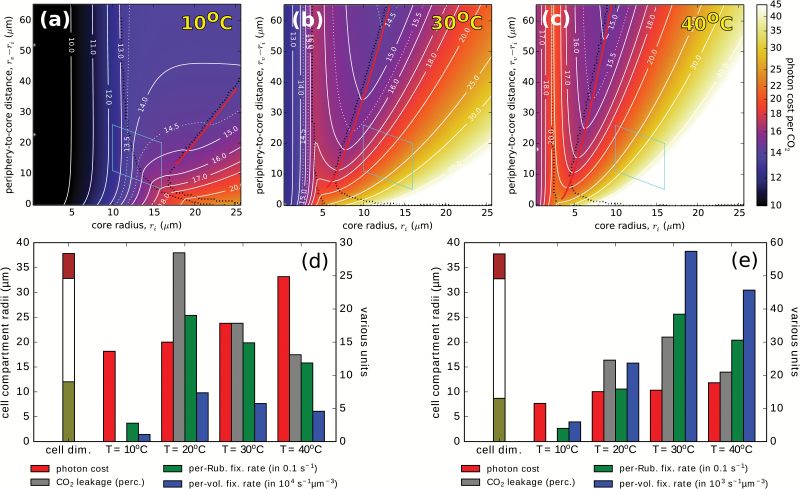
Temperature dependence of C4 photosynthesis. (a–c) C4-optimized photon cost landscapes at ambient temperatures of 10, 30, and 40 °C, plotted as Fig. 3 (20 °C). (d) and (e) Comparisons of the CO2 leakage, photon cost, and assimilation rates at two fixed cell geometries at various temperatures. The three compartment radii in (d) and (e) are marked on the left-most tricolour meters, and can be read on the left y-axis. The values of other quantities are to be read on the right y-axis. The comparison in (d) is taken at a point in the photon cost landscape that lies on the optimal-geometry line at 20 °C, with a photon cost (at 20 °C) of 15 photons per CO2. The comparison in (e) is taken at a point that lies on the optimal-geometry line at 30 °C, with a photon cost (at 30 °C) of 15.5 photons per CO2. The first point lies within the observed range of Bienertia cell dimensions; the second is positioned slightly outside this range. The CO2 leakage is zero at 10°C because both points lie within the C3 region of the photon cost landscape at that temperature. Parameters are as in Supplementary Table S1.